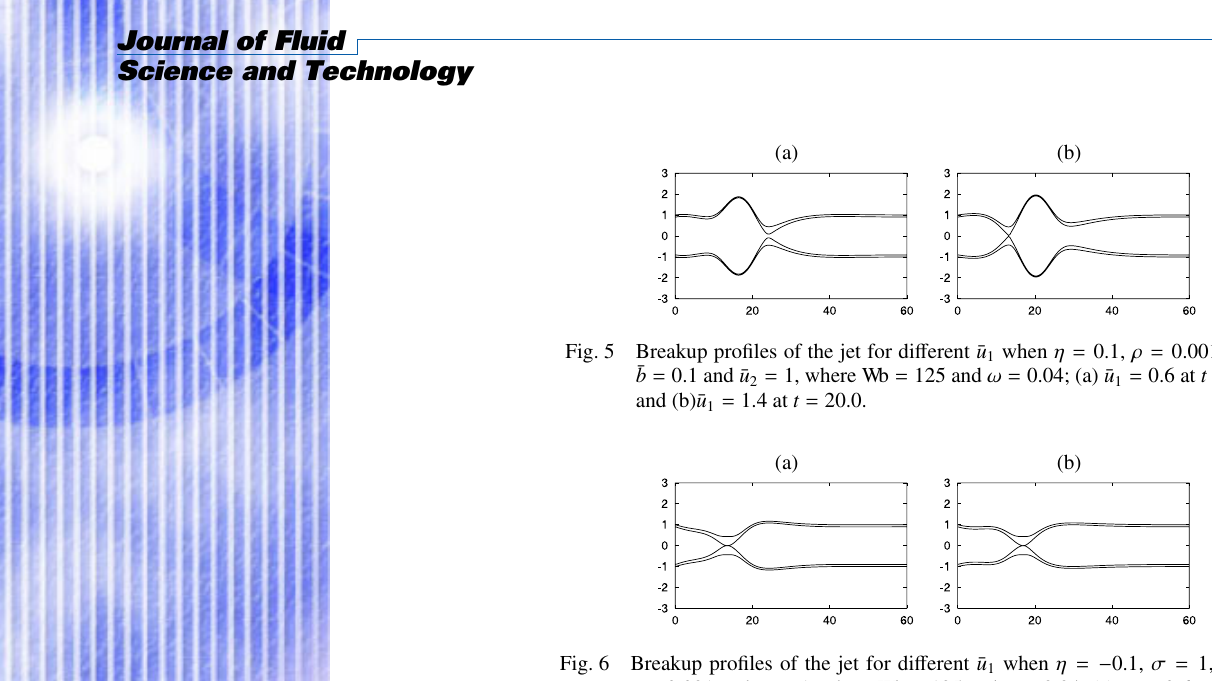
Fig. 6 Breakup profiles of the jet for di ff erent ¯ u 1 when η = − 0 . 1, σ = 1, ¯ b = 0 . 1, ρ = 0 . 001 and ¯ u = 1, where Wb = 125 and ω = 0 . 04; (a) ¯ u 2 and (b)¯ u 1 = 1 . 4 at t = 17 . 14.